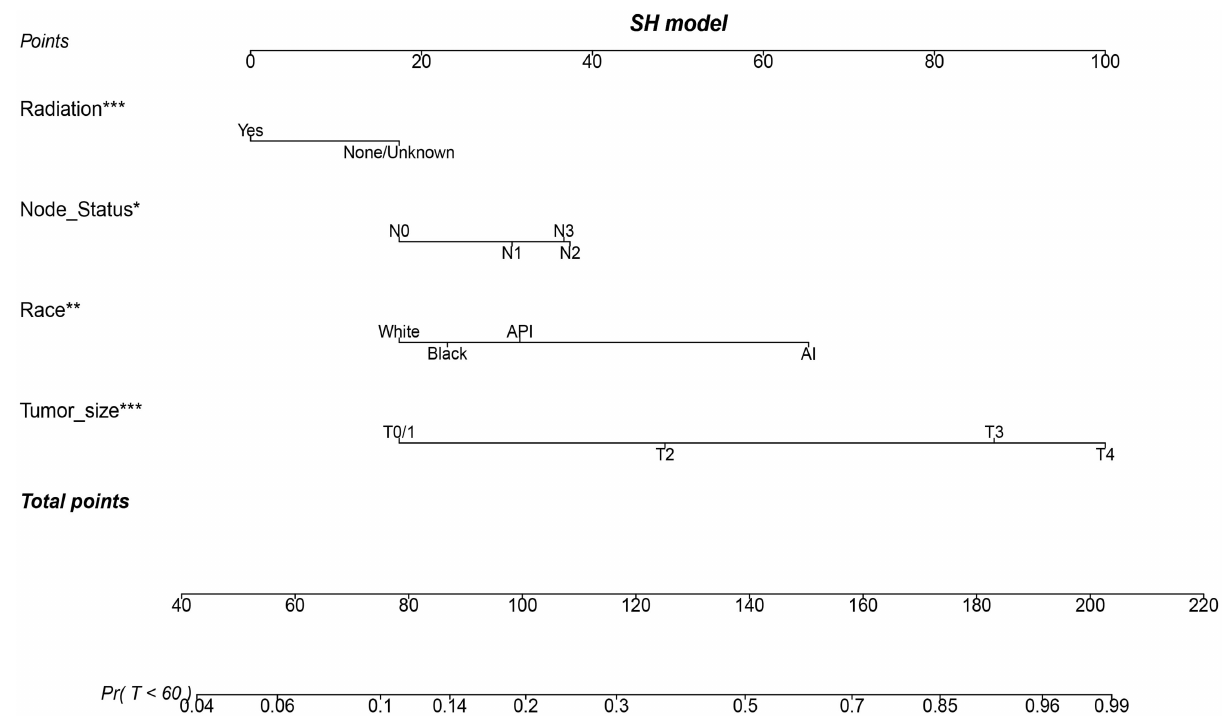
FIGURE 4 | A nomogram based on SH model for predicting 60-month risk of death of patients with metaplastic breast cancer (MBC). * p < 0.05, ** p < 0.01, and *** p < 0.001.